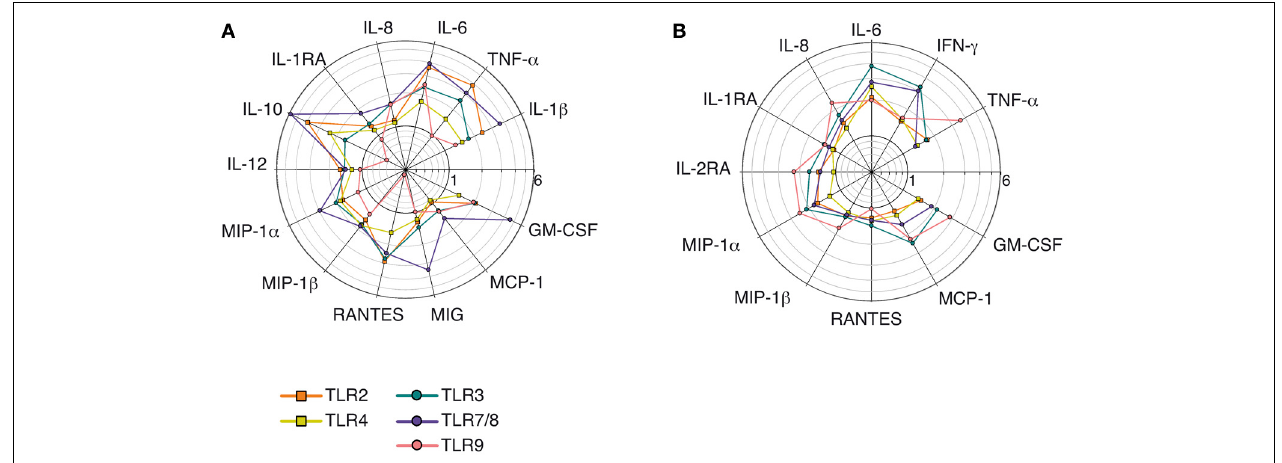
FIGURE 5 | Comparison of the cytokine profiles and median fold increases of cytokine secretion by dMs and dNK cells stimulated with TLR agonists. The median fold increases in